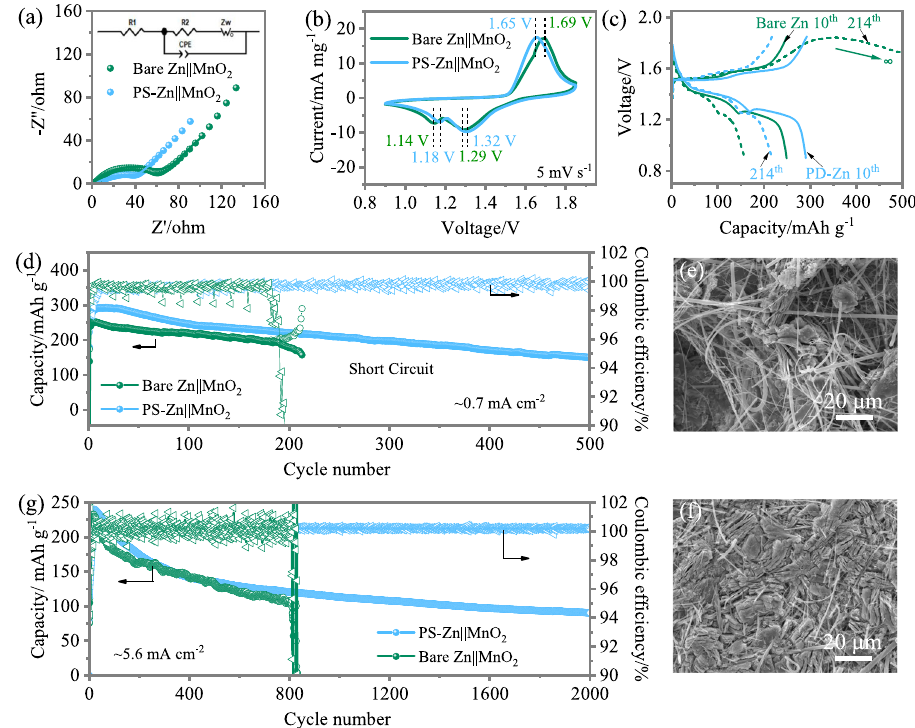
Fig. 6 Electrochemical characterizations of aqueous Zn||MnO 2 coin cells. a , b EIS and CV curves of the fresh PD-Zn||MnO 2 and bare Zn||MnO 2 cells; c , d GCD pro fi les and cycling performance at a speci fi c current of 0.5 A g − 1 with a positive electrode loading mass of 1.4 mg cm − 2 ; e , f ex situ SEM micrograph of the disassembled bare Zn after 214 cycles and PD-Zn after 500 cycles; g . cycling performance of PD-Zn||MnO 2 under a current density of 1 A g − 1 with a positive electrode loading mass of 5.6 mg cm − 2